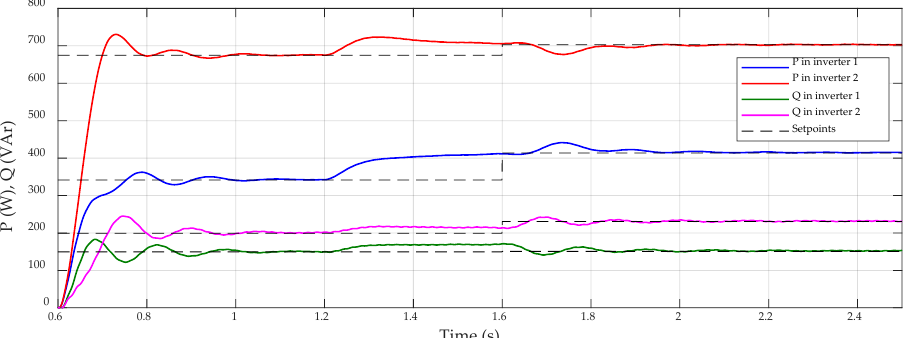
Figure 9. Active and reactive power output in both inverters, calculated from measured voltage and current values.